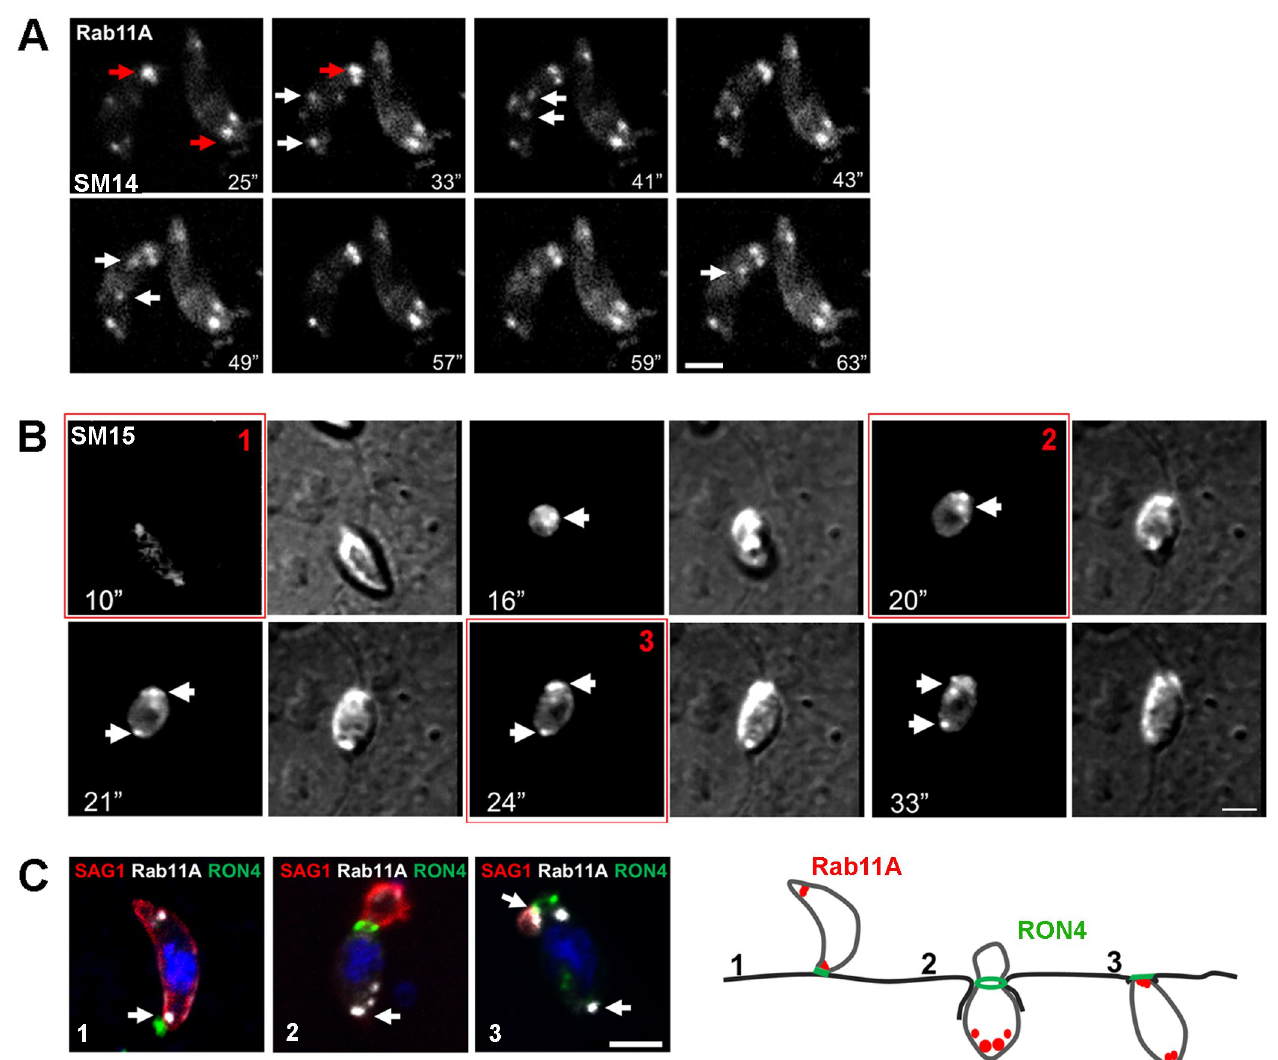
Fig 6. A - Sequences of images extracted from S14 Movie showing the polarized recruitment of mcherryRab11A-positive vesicles (white arrows) towards two main foci localized at the tip of adhering parasites (red arrows). Time is indicated in seconds. Bar: 2 μ m. B- Sequences of images extracted from S15 Movie showing a similar polarized localization of mcherryRab11A-positive vesicles (white arrows) during host cell invasion. At the end of parasite entry, Rab11A was also detected at the rear pole of the parasite. Time is indicated in seconds. Bar: 2 μ m. C- Fluorescence images of RH Δ KU80 parasites fixed at three different steps of the host cell invasion process, as indicated in the right scheme. The moving junction is labeled with RON4 (green) and the membrane protein SAG1 was used to label the extracellular portion of the invading parasite (red). Bar: 2 μ m.